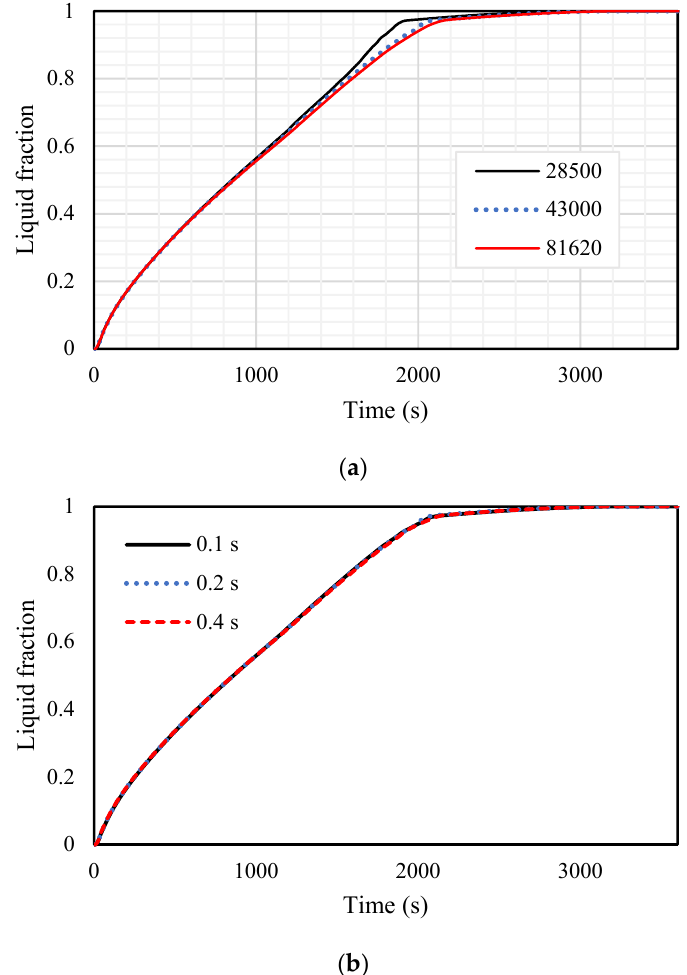
Figure 3. The variation of liquid fraction for different ( a ) sizes of the gird and ( b ) size of time step. The mesh with the grid numbers of 43,000 is illustrated in Figure 4.